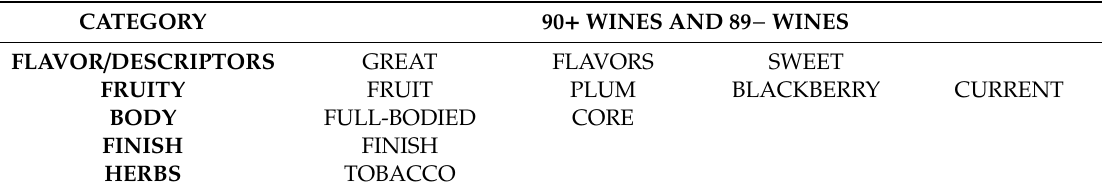
Table 6. Common keywords between 90 + and 89 − wines from 1855 Bordeaux Wine O ffi cial classification dataset.